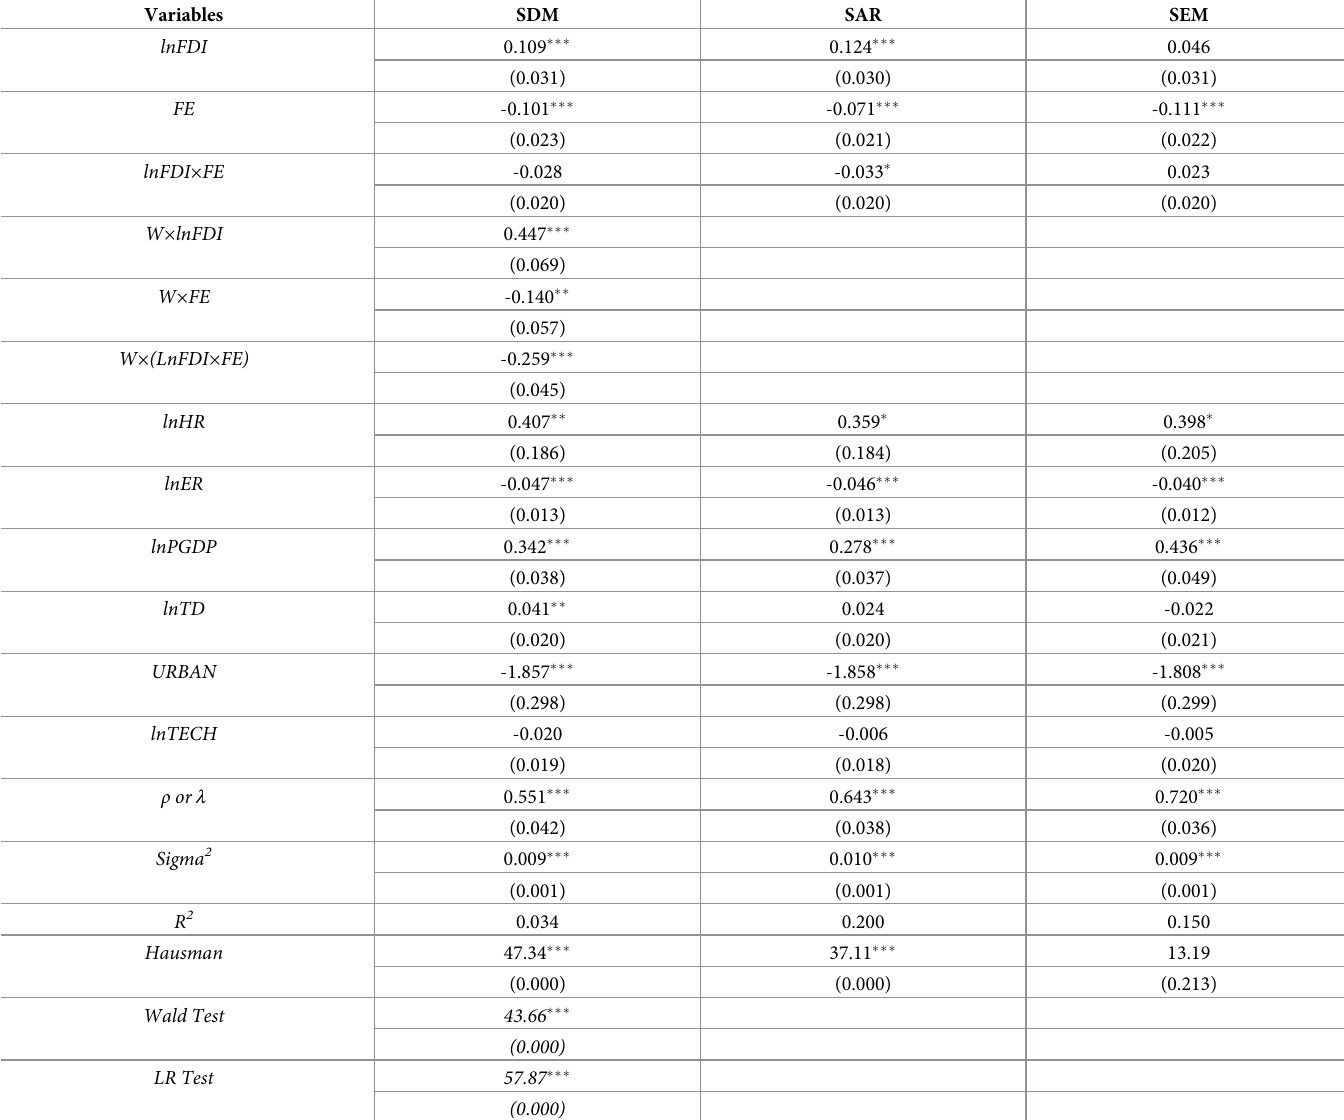
Table 7. The results of baseline SDM, SAR and SEM regression.